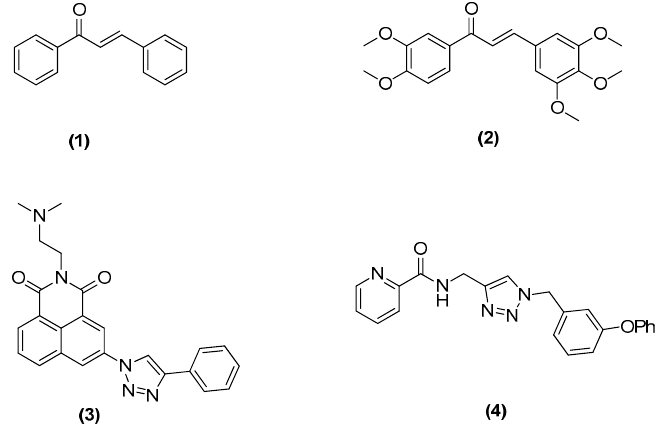
Figure 1. Structures of chalcone and 1,2,3-triazole derivates as antitumor agents previously reported.